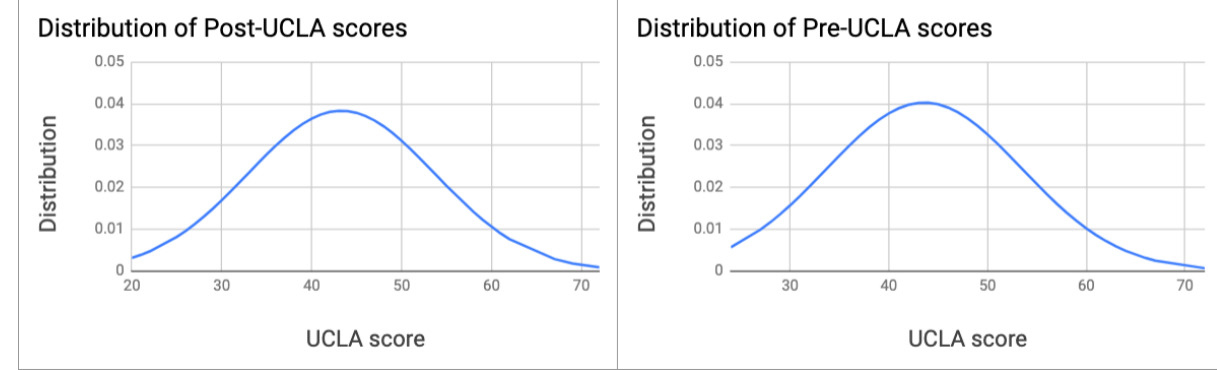
Figure 4. Distribution of presemester University of California, Los Angeles, scores (mean 43.6, SD 9.4) and postsemester University of California, Los Angeles, scores (mean 43.3, SD 10.4). UCLA: University of California, Los